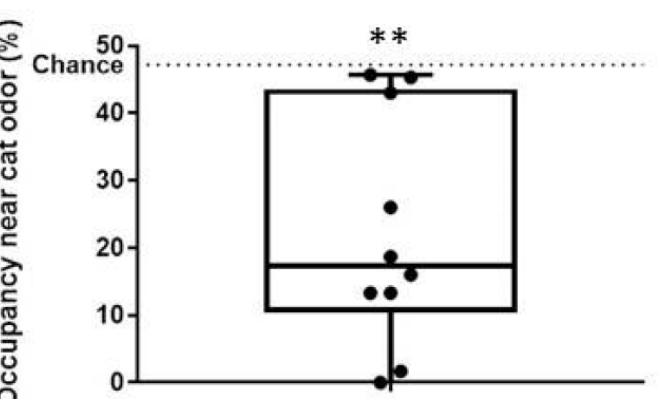
Figure 3. Aversion to bobcat urine in male rats used during the experiment. Ordinate depicts occupancy in the cat odor bisect of the arena, and the dashed line represents theoretical expectancy based on chance alone. Each dot represents the raw data from one male rat. Box plot depicts median, 25th percentile, and 75th percentile. ** p < 0.005; one ‐ sample t ‐ test against the chance of 47.2%.